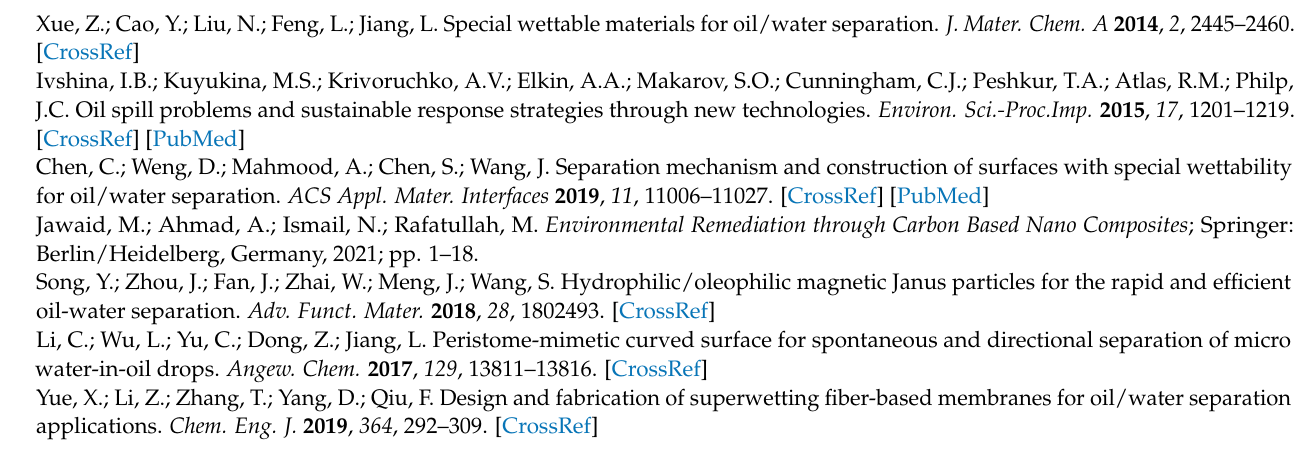
(d) 760 nm; Figure S2: diagram of three particles in liquid (yellow for oil phase, blue for water phase); Figure S3: photograph of separation of n-heptane emulsions with different concentrations mediated by Janus particles: (a) 0.5 %, (b) 5 %, (c) 7 %; Figure S4: photograph characterization of Janus particle- mediated separation of toluene (a) and cyclohexane (b) emulsions at the same concentration (3